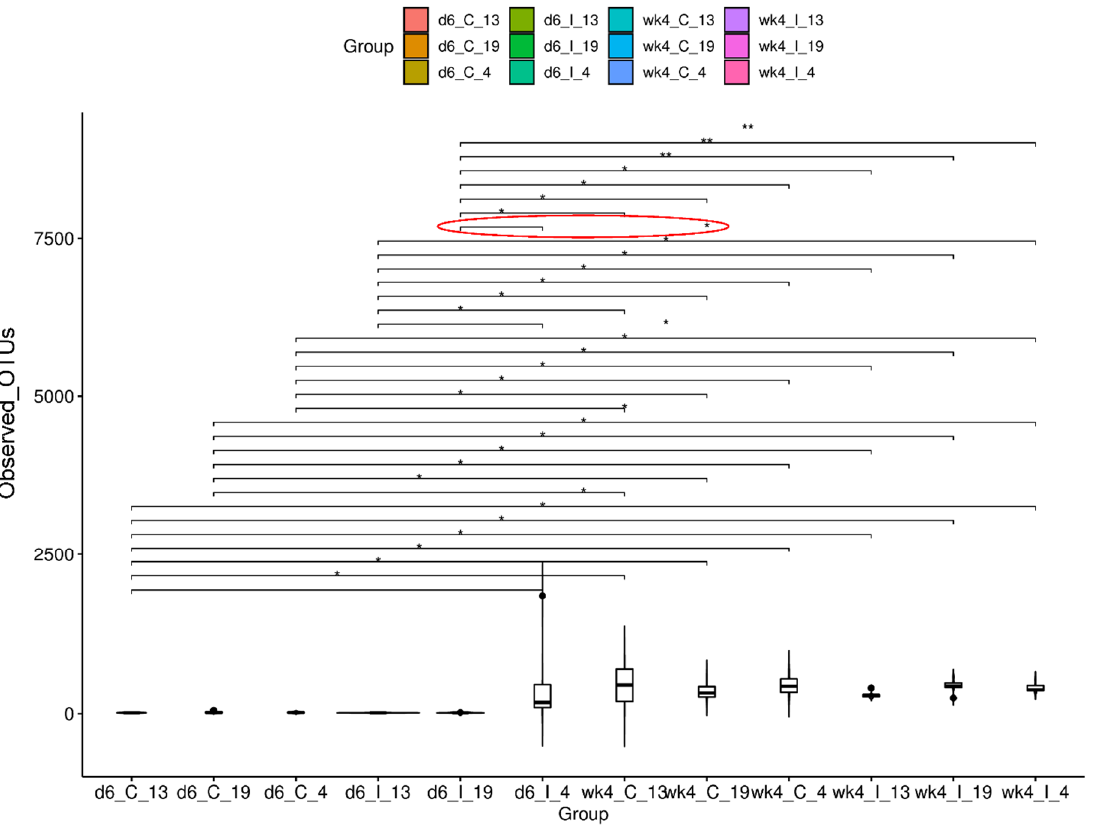
Figure 2. Alpha diversity of beet curly top virus (BCTV)-susceptible (19) and BCTV-resistant (13, 4) sugar beet genotypes with and without BCTV infection at early (day 6; d6) and late (week 4; wk4) time points. Observed OTU boxplot and Kruskal–Wallis pairwise comparisons (* p < 0.05, ** p < 0.01). C = uninfected control, and I = BCTV-infected. The significant difference between d6_I_4 and d6_I_19 (as mentioned in the text) is shown through red-lined ellipse. The data are mean ± standard error of four replicates (uninfected control) and five replicates